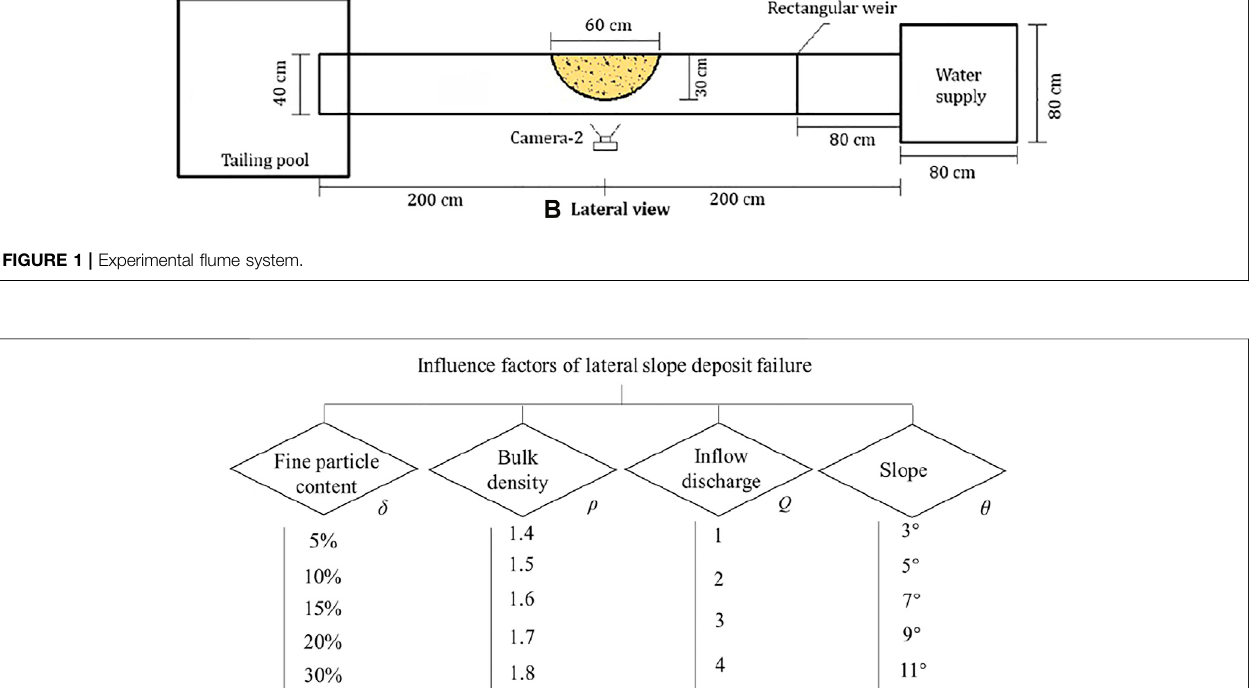
Frontiers in Earth Science |